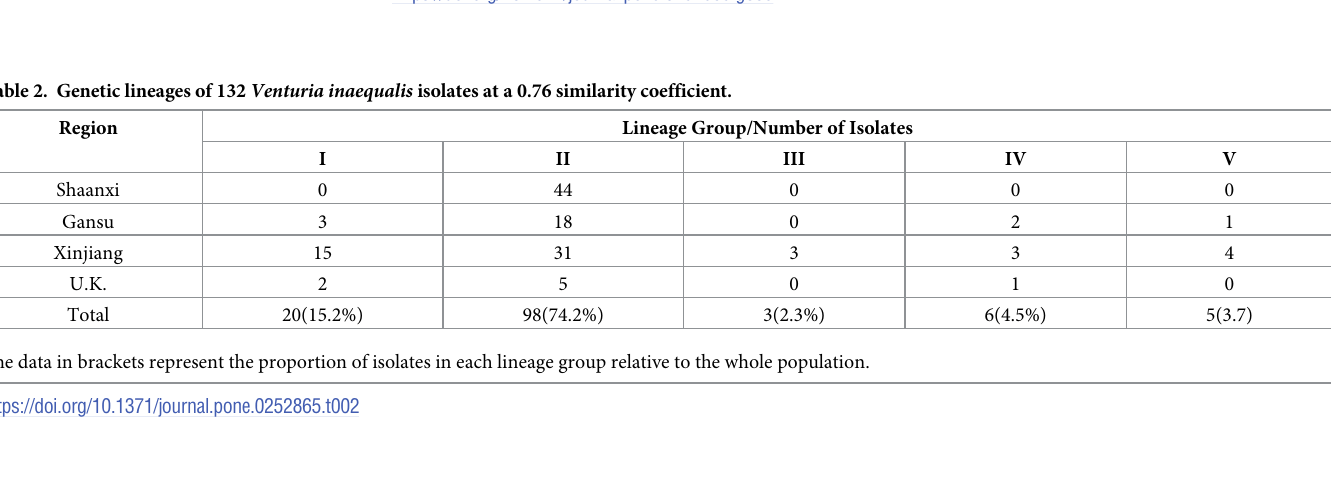
Fig 3. UPGMA dendrogram depiciting the genetic relationship among 132 isolates of Venturia inaequalis based on 13 SSR markers.